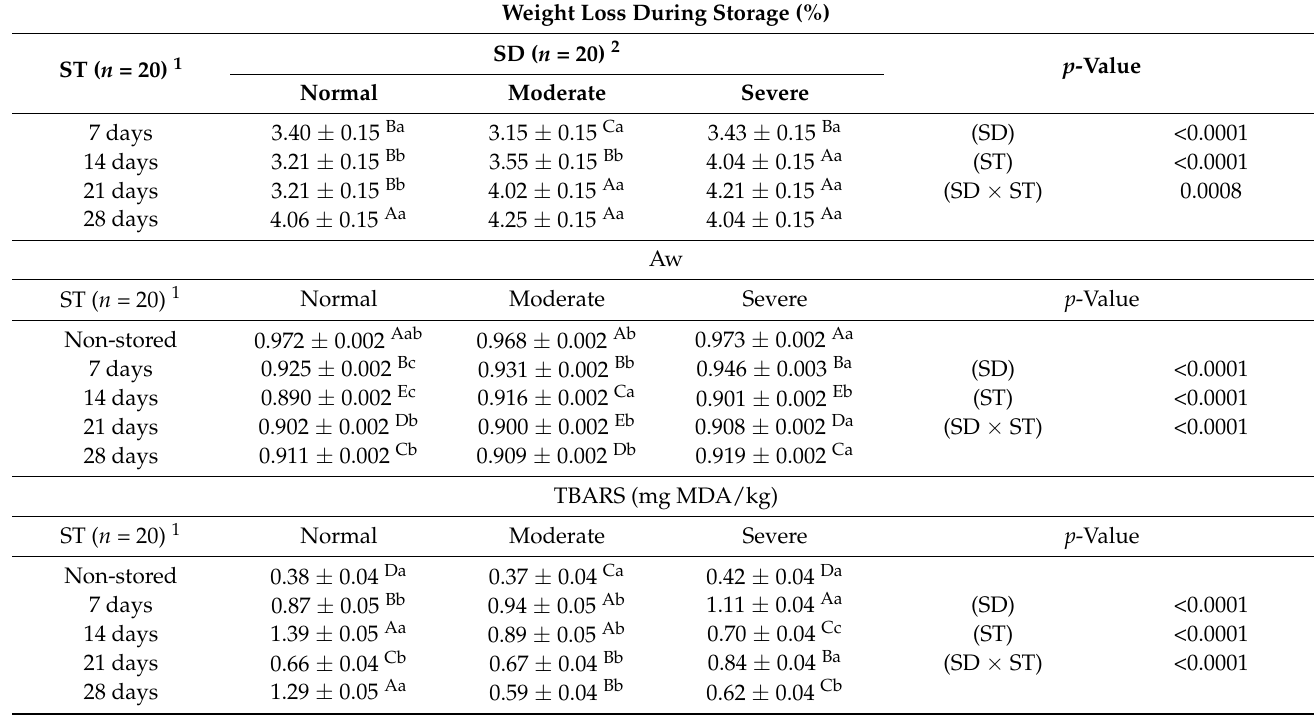
Table 3. Mean values of weight loss during storage, water activity (Aw) and lipid oxidation (TBARS) in fresh sausages produced with breast meat from Ross (AP95) broiler chickens without myopathies and affected by wooden breast myopathy after different storage